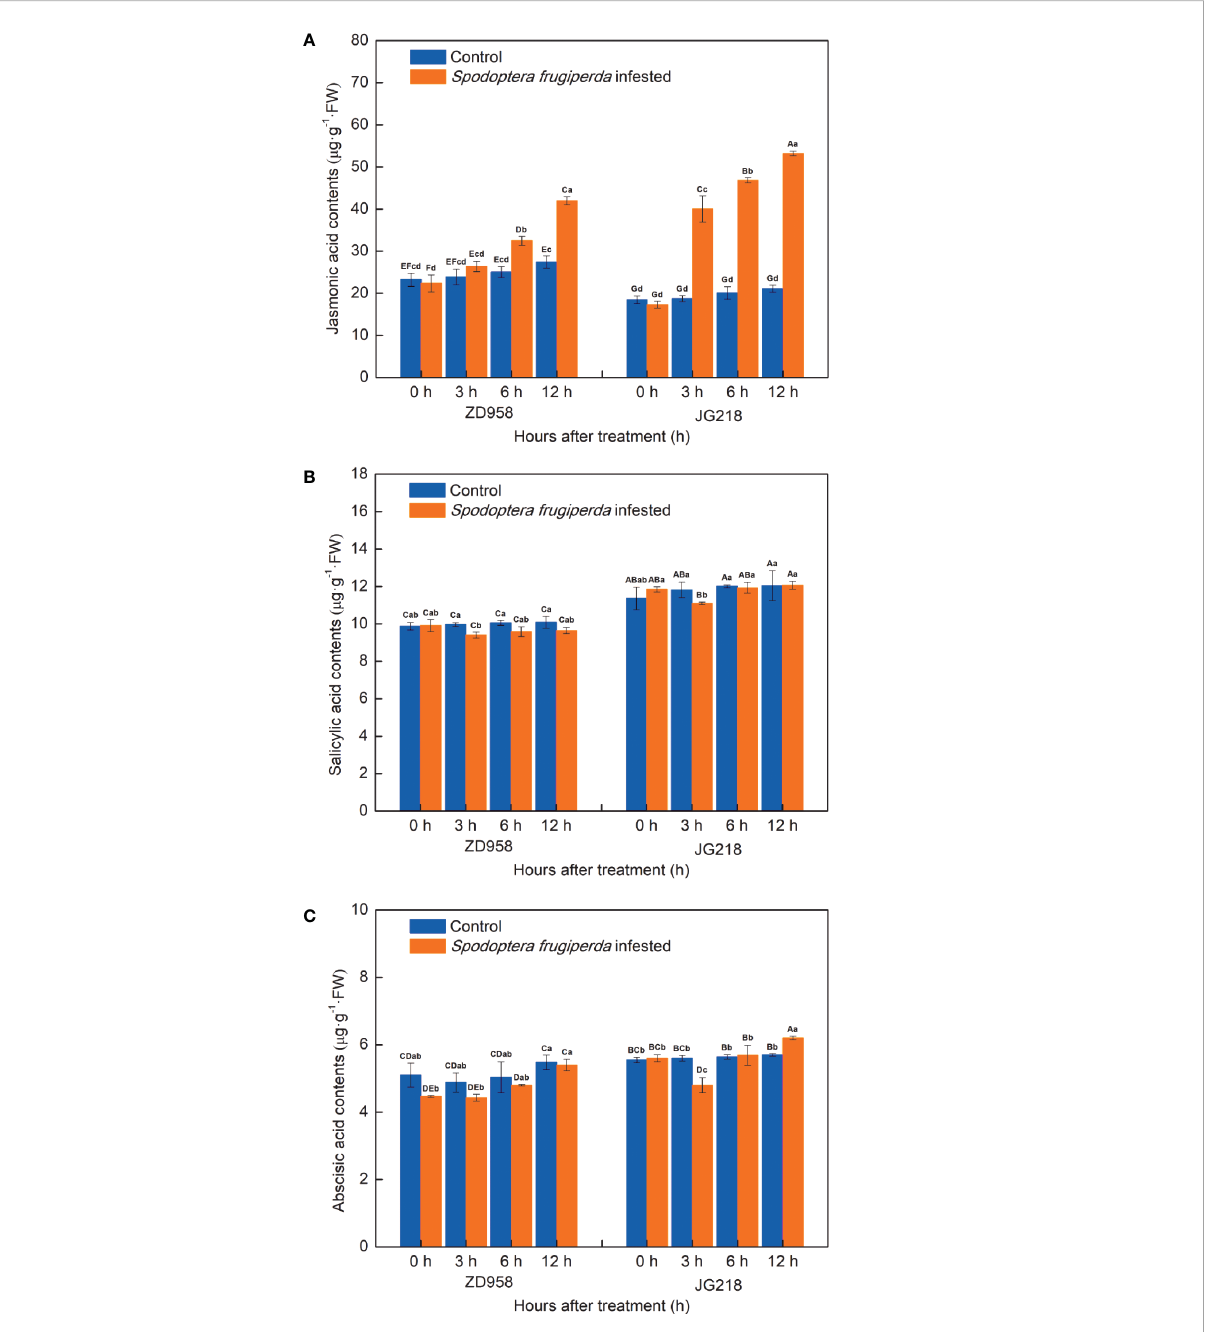
FIGURE 8 Effect of S. frugiperda infestation on salicylic acid (A) , jasmonic acid (B) , and abscisic acid (C) contents in maize leaves. Data are shown as means ± SD ( n = 3, every n represents the mean of three seedlings). Different letters indicate signi fi cant differences at P < 0.05. Capital letters represent differences between the two maize cultivars, while lowercase letters indicate differences between treatments within the same